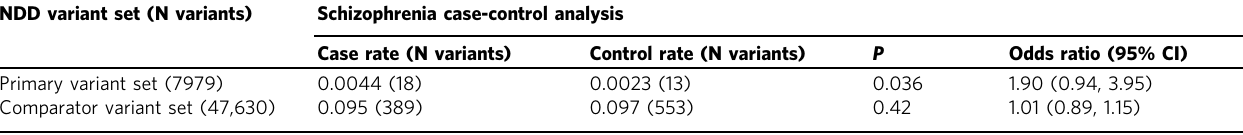
Table 4 Schizophrenia case-control analysis of neurodevelopmental disorders